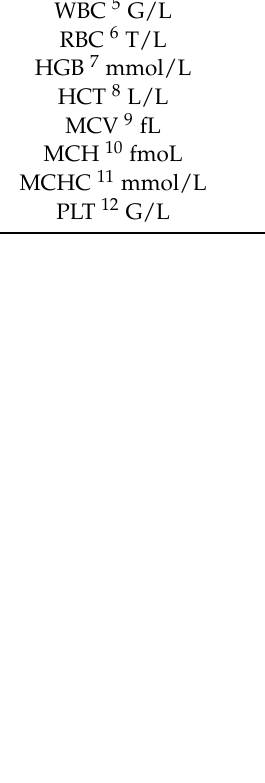
Table 5. Hematological parameters in Zucker rats after treatment with saponin and terpenoid fractions. CON 1